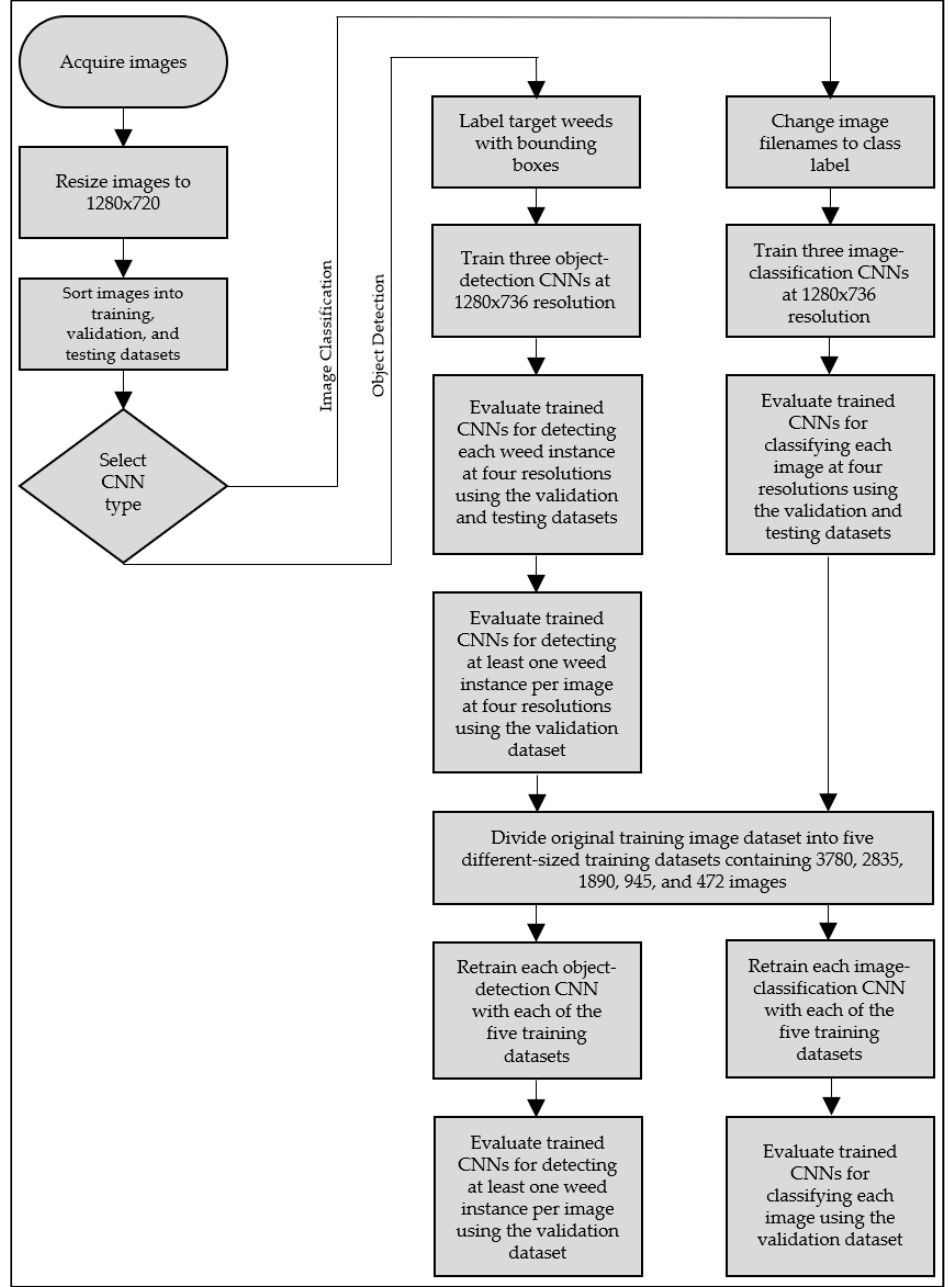
Figure 2. Flowchart of data sorting, training and evaluation procedures used in this study.